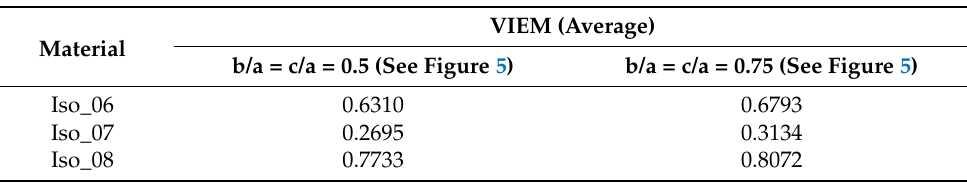
22 of 44 Figure 17. A typical discretized oblate spheroidal model (b/a = c/a = 0.75) in the volume integral equation method (VIEM). ( a ) An inside view of an oblate spheroidal model. ( b ) An oblate spheroidal model. Eight different isotropic inclusions (from Iso_01 to Iso_08) in Table 2 were used in the numerical calculation. It should be noted that the VIEM results represent average values of the normalized stresses in all the nodes of the VIEM model in Figures 16 and 17. It should also be noted that the normalized tensile stress ( σ xx / σ oxx ) inside the isotropic oblate